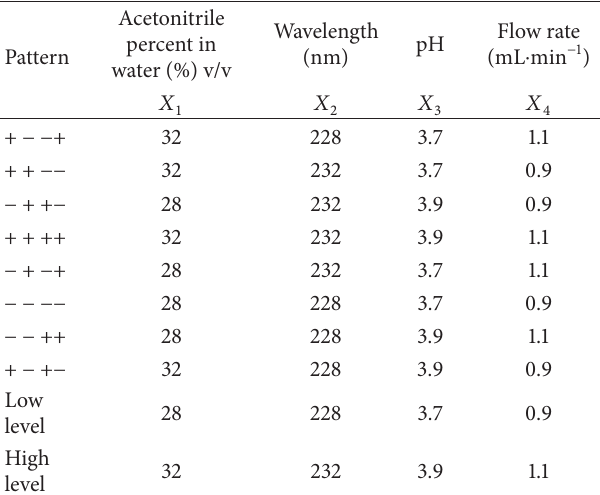
Table 1: Experimental design matrix for the robustness study and response values ( 𝑛 = 5